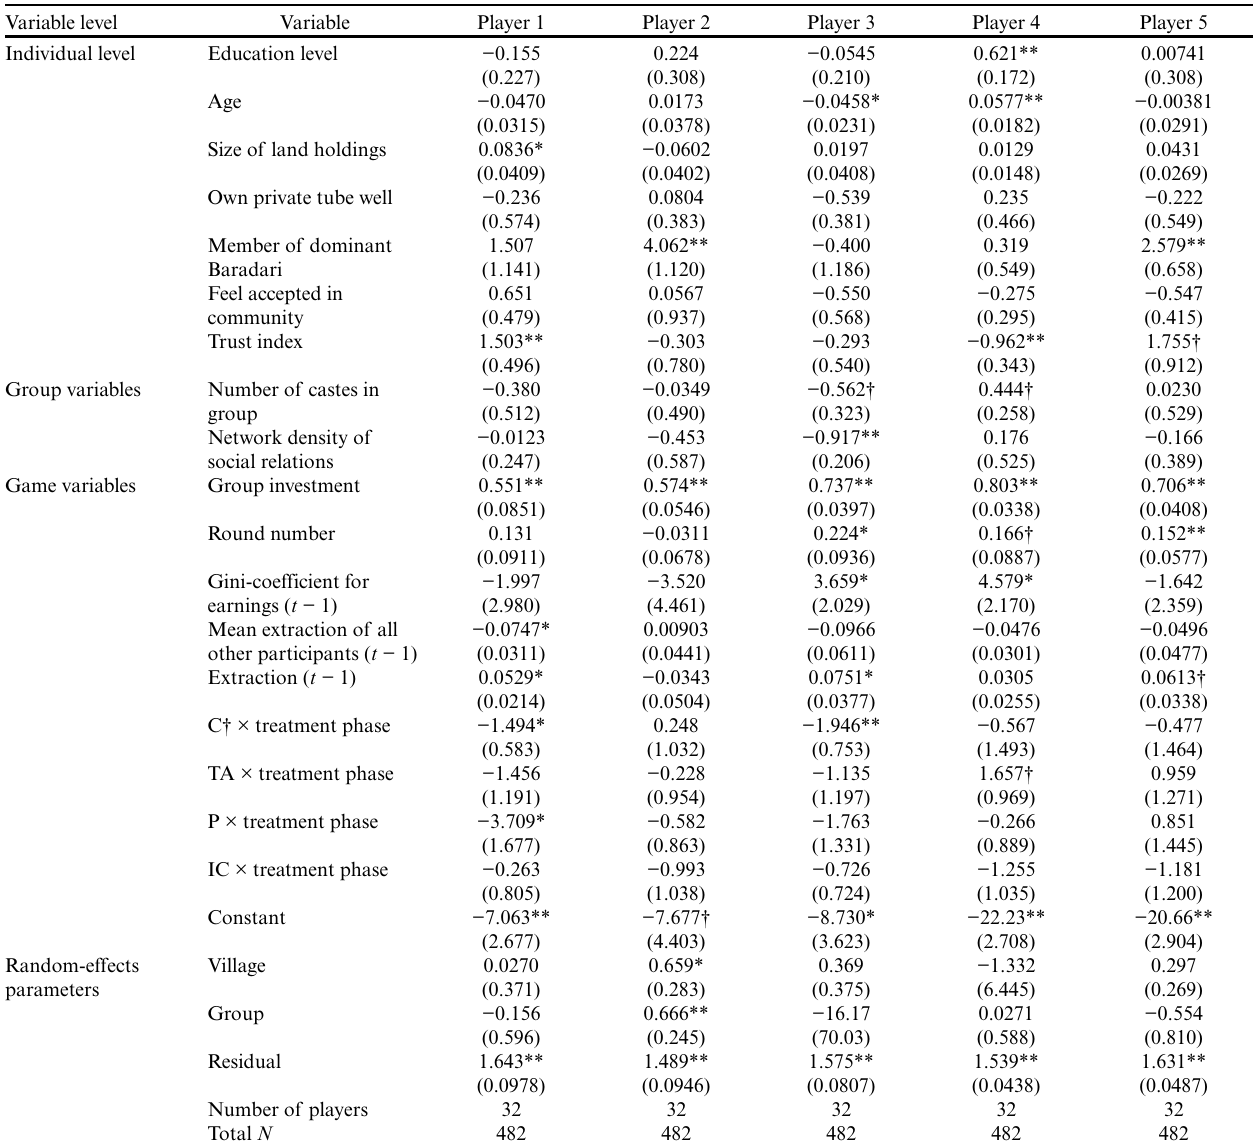
Table 3. Mixed-effects regression results explaining the total tokens earned from water extraction depending on player position. Numbers are coefficients, with robust standard errors in